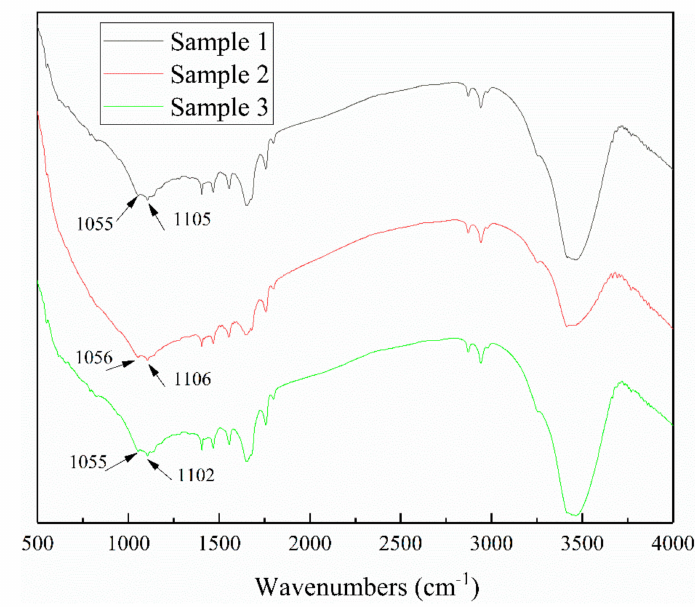
Figure 7. FTIR of the three samples after reaction with xanthate.